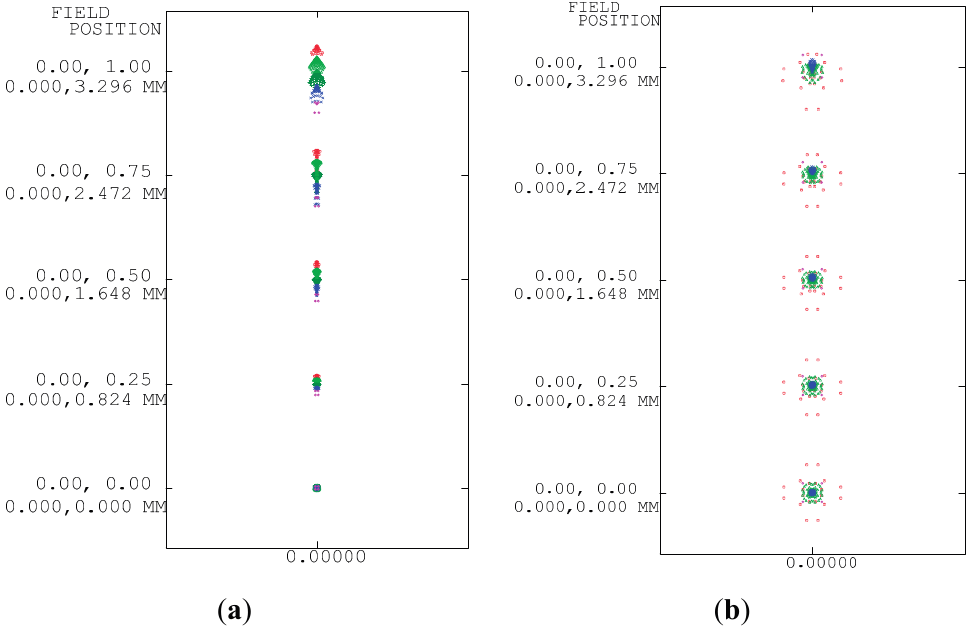
Figure 6. The spot diagram of 9× zoom lens for intermediate optics design.